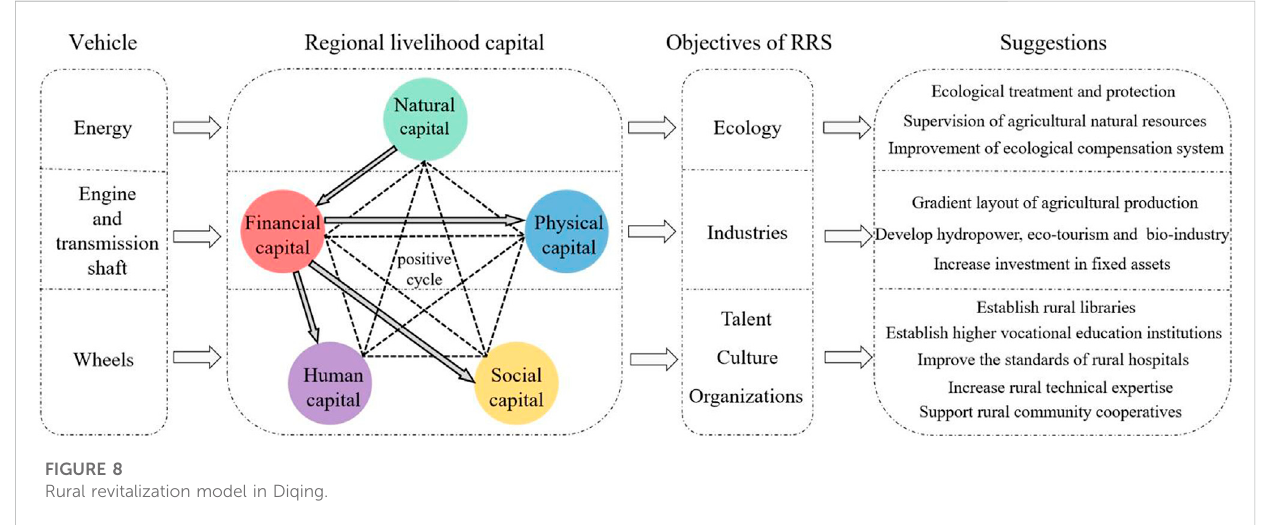
FIGURE 8 Rural revitalization model in